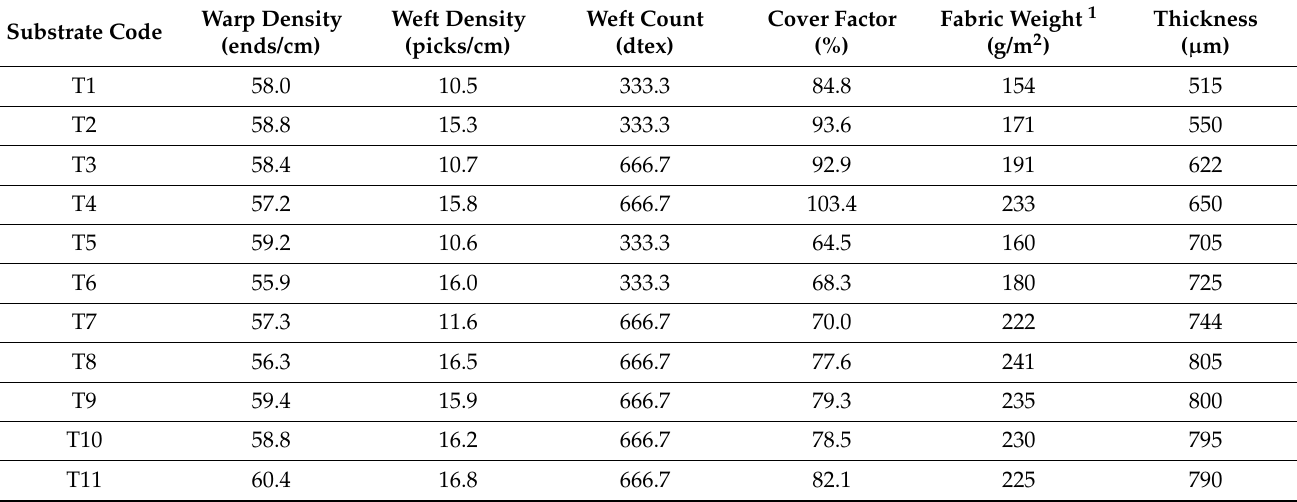
Table 2. Textile substrate’s characterization (II): size and weight characteristics.